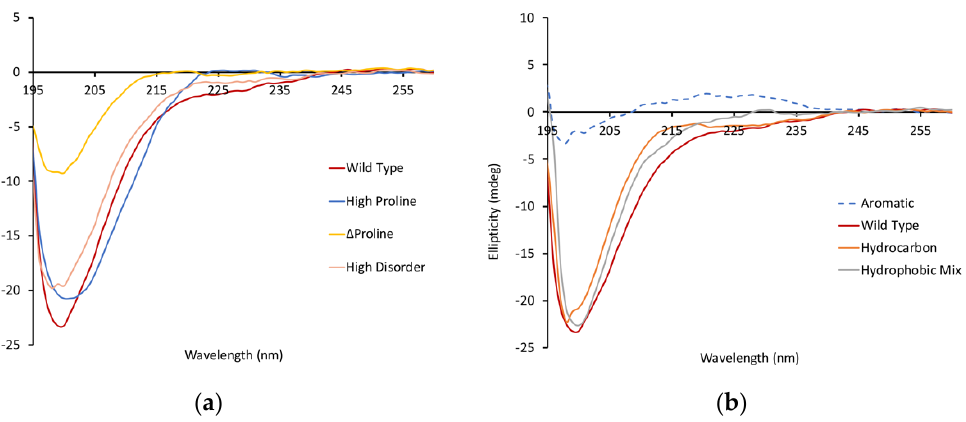
Figure 3. Peptides showing disordered characteristics at pH 7. CD spectra were collected for each peptide at pH 7 as a baseline. The majority of the peptides exhibited the characteristic 200 nm minima associated with a disordered structure. The ∆ proline peptide ( a ) has a reduced minimum, suggesting that this peptide might have a small degree of ordered structure. The aromatic peptide ( b ) did not show any minima at 200 nm. The concentration of all peptides is 80 µ